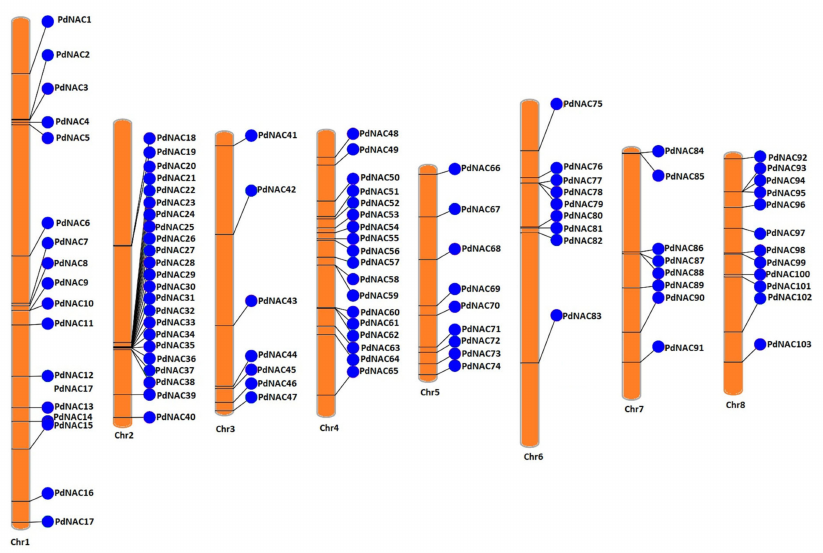
Figure 1. Chromosomal mapping of PdNAC genes. PdNAC genes have been predicted on the chromosomes of P. dulcis . Chromosome numbers is present below each